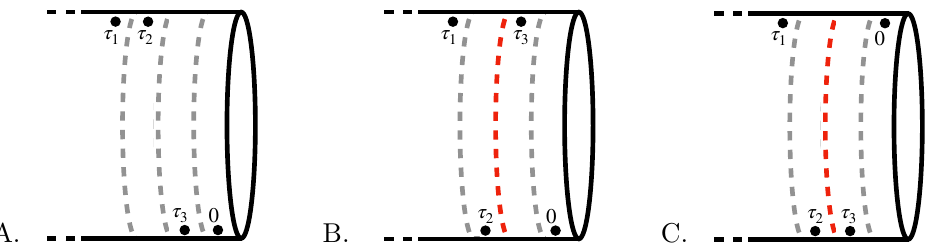
Figure 1 . Diagrams representing the three leading singularities of the four point function on the cylinder. The points are all time ordered but have been given angular coordinates so as to position them in the different singular regions. The dashed lines are placed on surfaces of constant τ , where partial resolutions of the identity P ∆ k 6 ∆ T | k i h k | are inserted when HT regularisation is used. The k red dashed lines are discussed in the